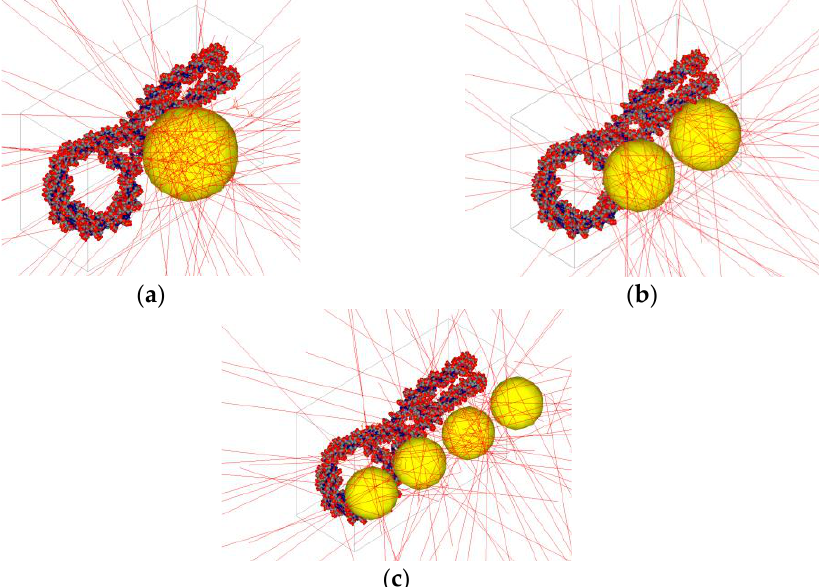
Figure 3. ( a ) OpenGL visualization of the irradiated single gold nanoparticle with a radius of 5 nm and a DNA molecule. ( b ) OpenGL visualization of the irradiated single gold nanoparticle with a radius of 3.97 nm and a DNA molecule. ( c ) OpenGL visualization of the irradiated single gold nanoparticle with a radius of 3.15 nm and a DNA molecule. The red tracks represent the secondary electron paths in the simulation.